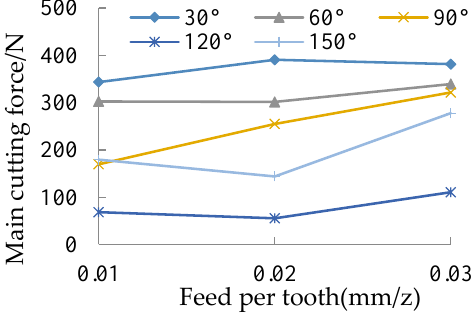
Figure 10. Influence fiber-cutting angle on the main cutting force.